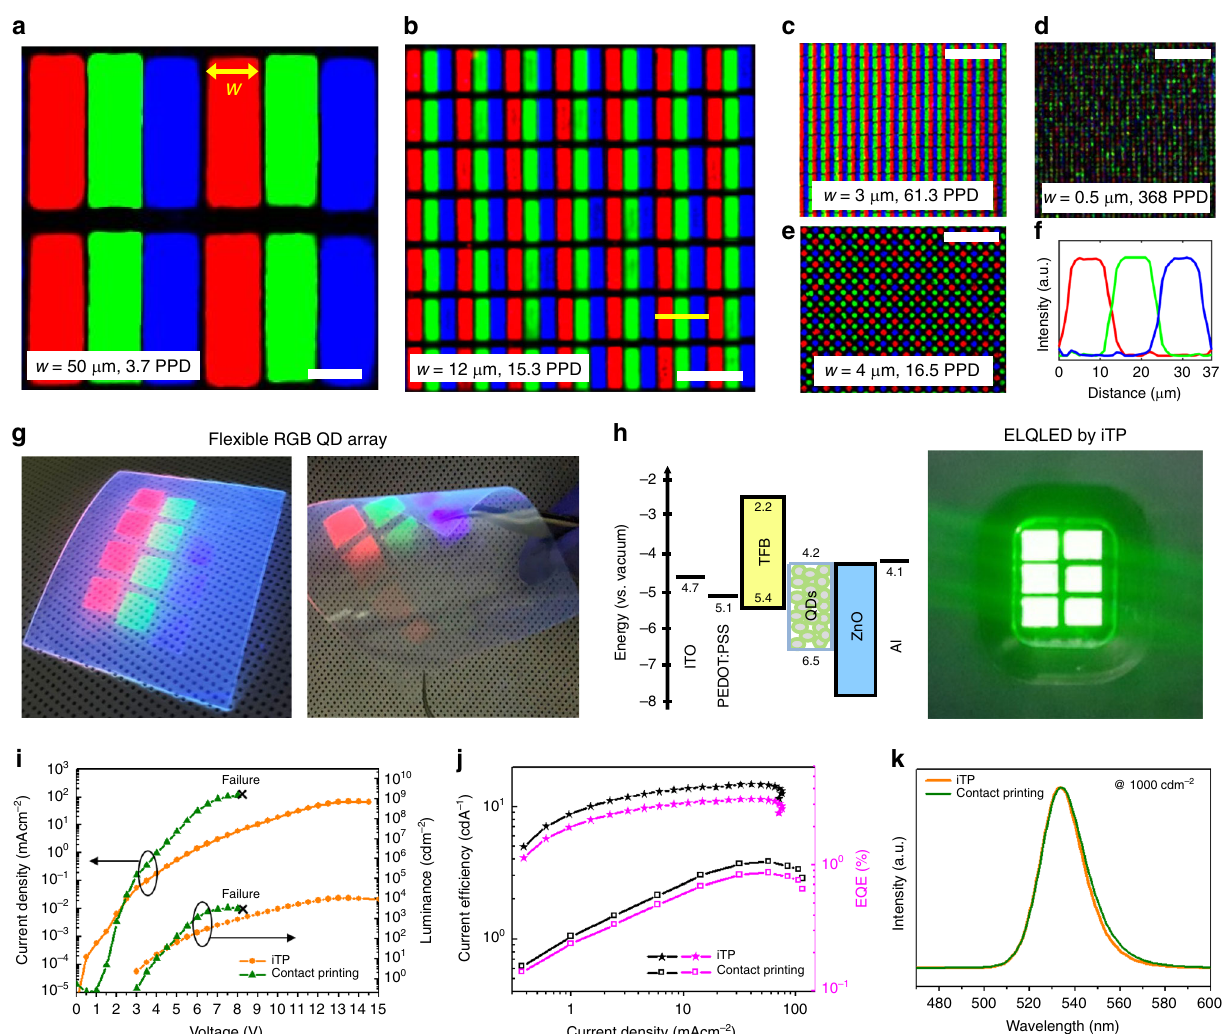
Fig. 5 Fabrication of RGB full-color QD array and ELQLED device using iTP. a – e Confocal fl uorescence images of full-color RGB QD arrays in wide resolution range with highest resolution of 368 PPD ( d ). Feature width of subpixels, w, and resolution in PPD (viewing distance of ×1.5 the diagonal length of the display) are denoted in the images. Hexagonal pentile array design is also demonstrated ( e ). Scale bars denote 50 µ m. f RGB pro fi le is plotted across a single pixel of the QD array in b (pro fi le marked in yellow) using imageJ. g RGB QD fi lm arrays printed on fl exible PET substrate using iTP. ( h ) Energy band diagram of the monochromatic green ELQLED fabricated using iTP (left), and photograph image of the operating device (right). i Current density – voltage – luminance ( J – V – L ) characteristics (symbol Χ indicates early failure of the contact-printed device), j Current ef fi ciency and external quantum ef fi ciency ( CE-EQE ) characteristics, and k Normalised electroluminescence (EL) spectra of ELQLED devices fabricated using iTP and contact